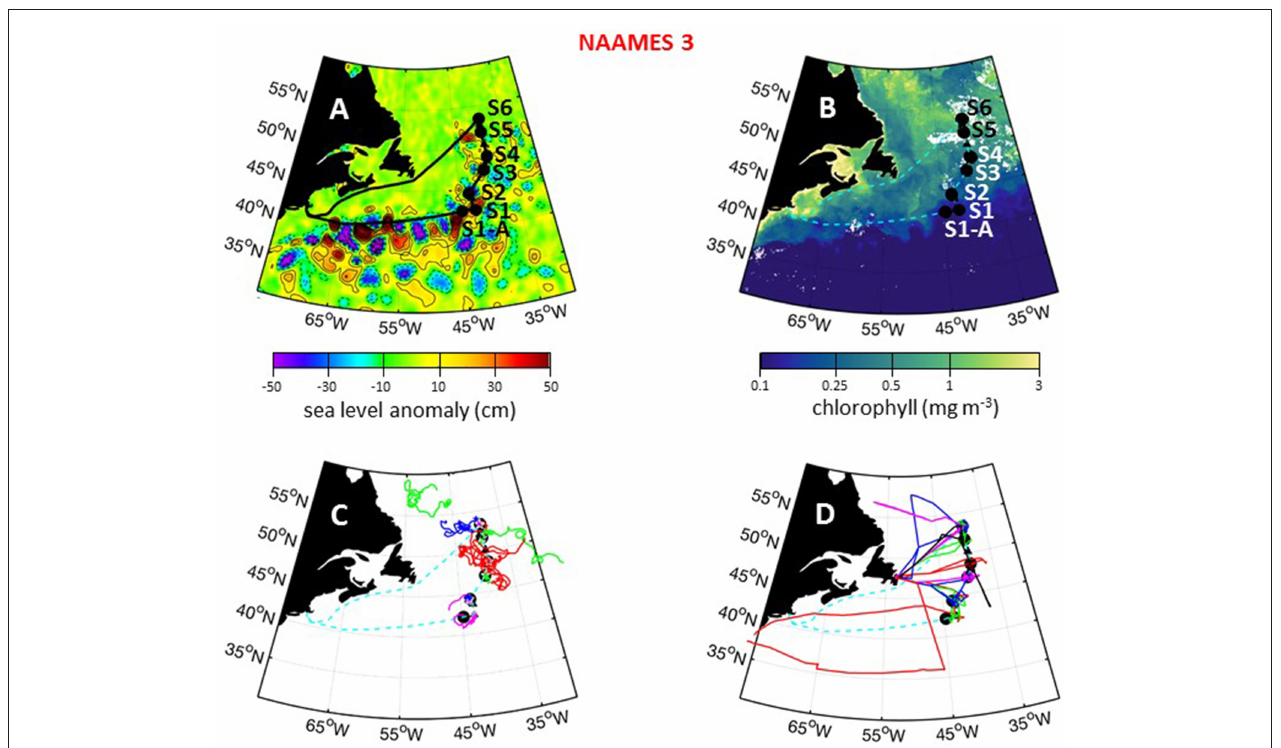
FIGURE 11 | NAAMES 3 primary stations, autonomous floats, and flight tracks. (A) Black line = ship transit. Labeled black circles = primary sampling stations. Black triangles = in-between stations. Background color = sea surface height anomalies highlighting anticyclonic and cyclonic mesoscale eddies in red and blue/purple, respectively. (B) Climatological surface chlorophyll concentrations for the NAAMES 3 period from satellite ocean color measurements. (C) Thirty-day trajectories for floats deployed during NAAMES 3 and 130 days for floats deployed before NAAMES 3. Star = float deployment site. (D) C-130 flight paths for the NAAMES 3 airborne campaign. Background color = logarithm of MODIS surface chlorophyll concentration averaged over the campaign. Broken cyan line in (B–D) = ship